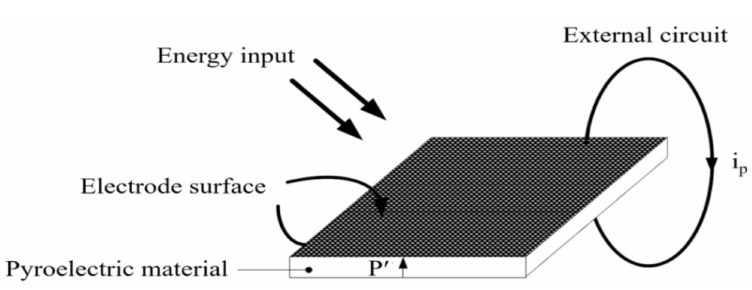
Figure 1. Principle of pyroelectric effect